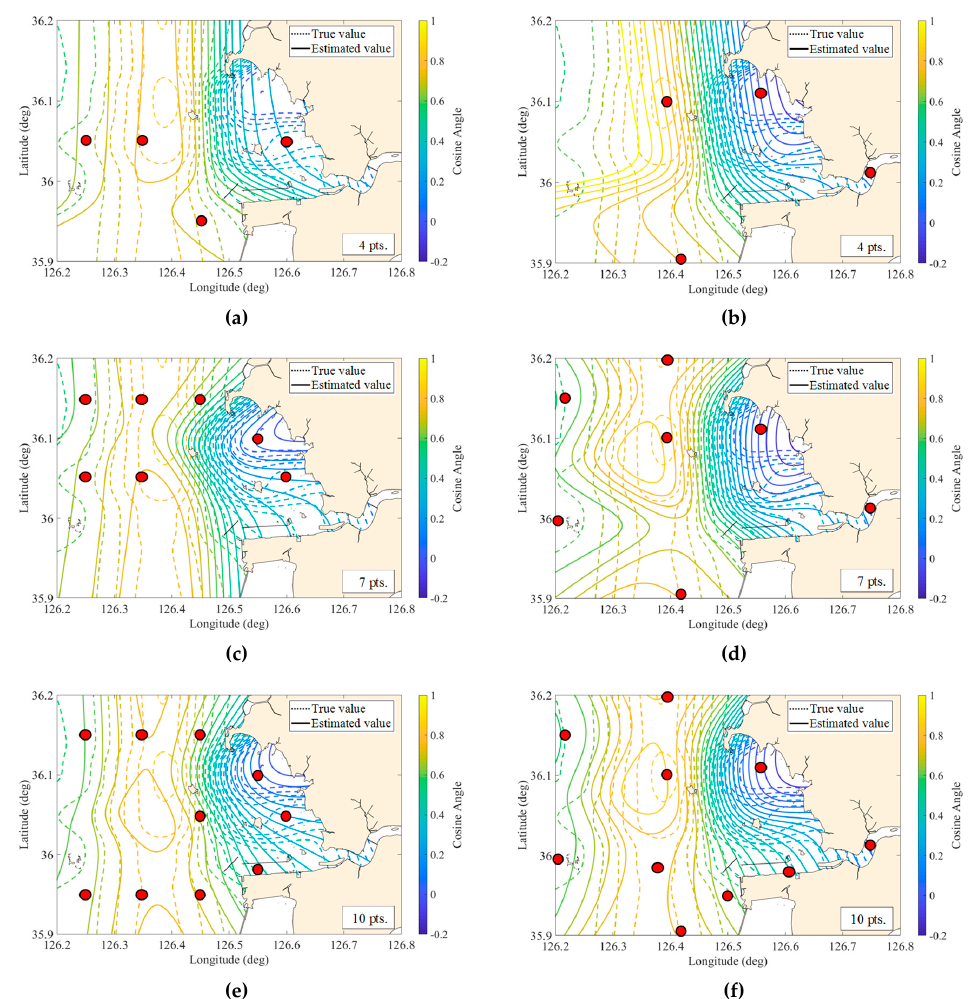
Figure 5. Comparison of the spatial distribution between true and estimated field reconstructed by using 4 ( a and b ), 7 ( c and d ), and 10 ( e and f ) points of the monitoring array, based on the quantitative optimization (left) and graphical optimization (right).